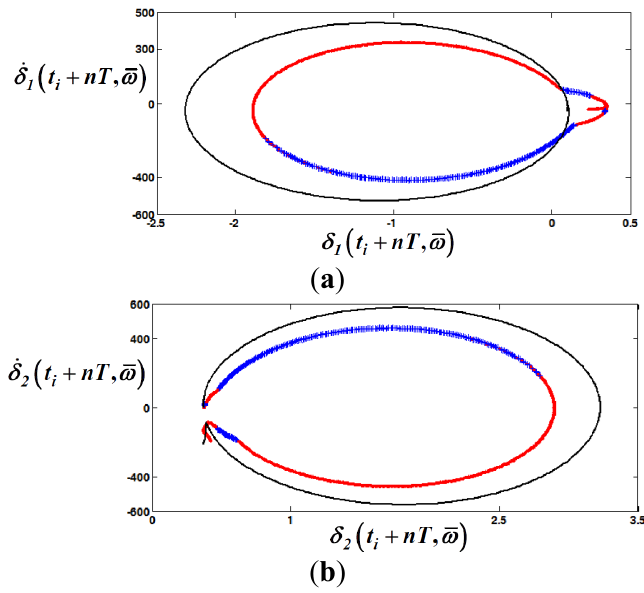
Figure 5. Comparison of Poincaré maps between nonlinear and linear models: ( a ) Poincaré t nT   vs.   , t nT    along with the excitation frequency; and map of   , 1 i 1 i t nT   vs.   , t nT    along with the excitation ( b ) Poincaré map of   , 2 i 2 i